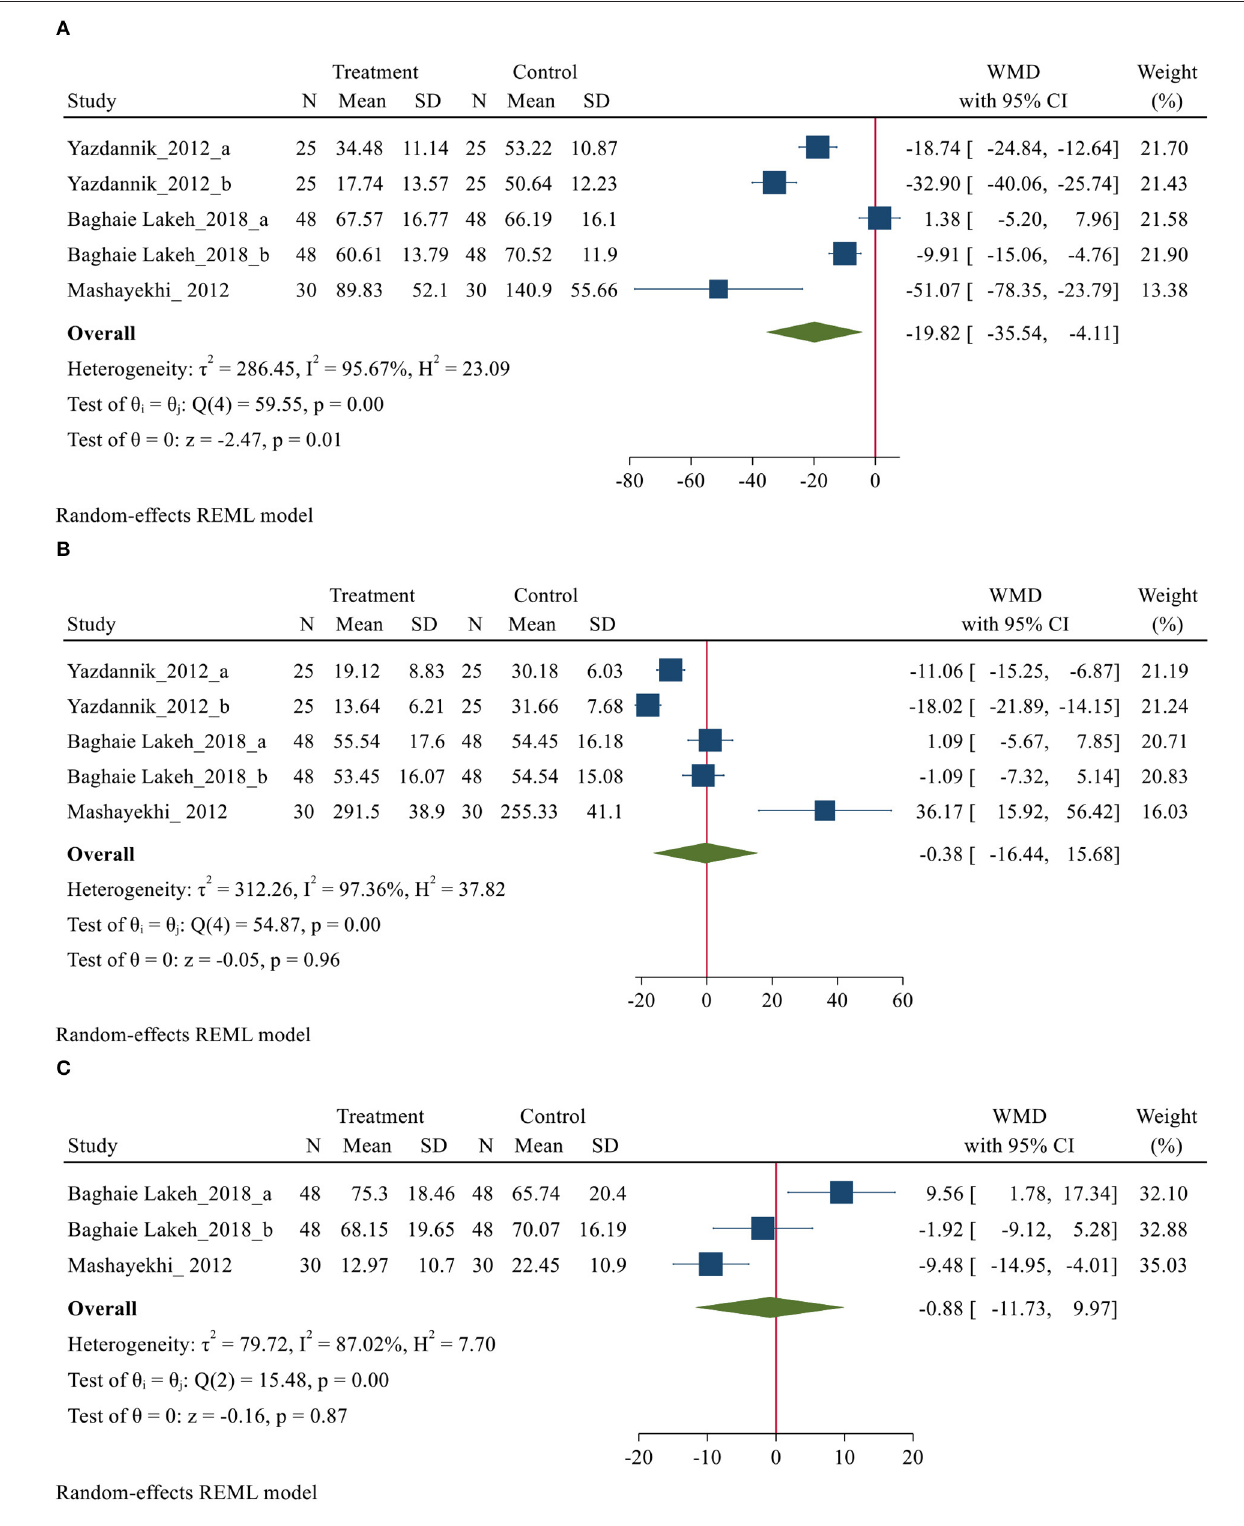
Frontiers in Psychiatry |